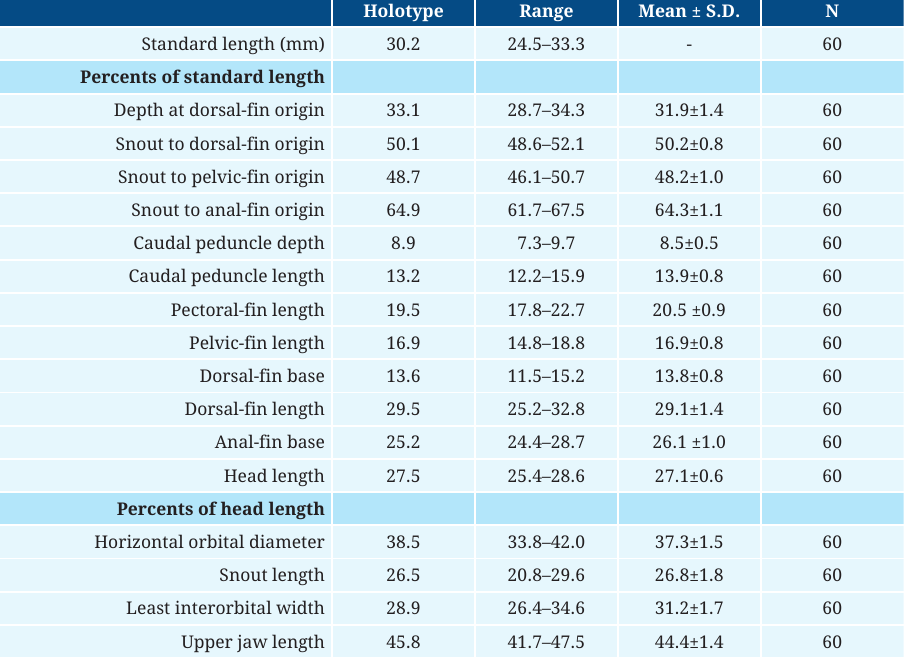
TABLE 1 | Morphometric data for Hyphessobrycon cantoi . N = number of specimens measured. S.D = Standard deviation. Holotype measurements included in the